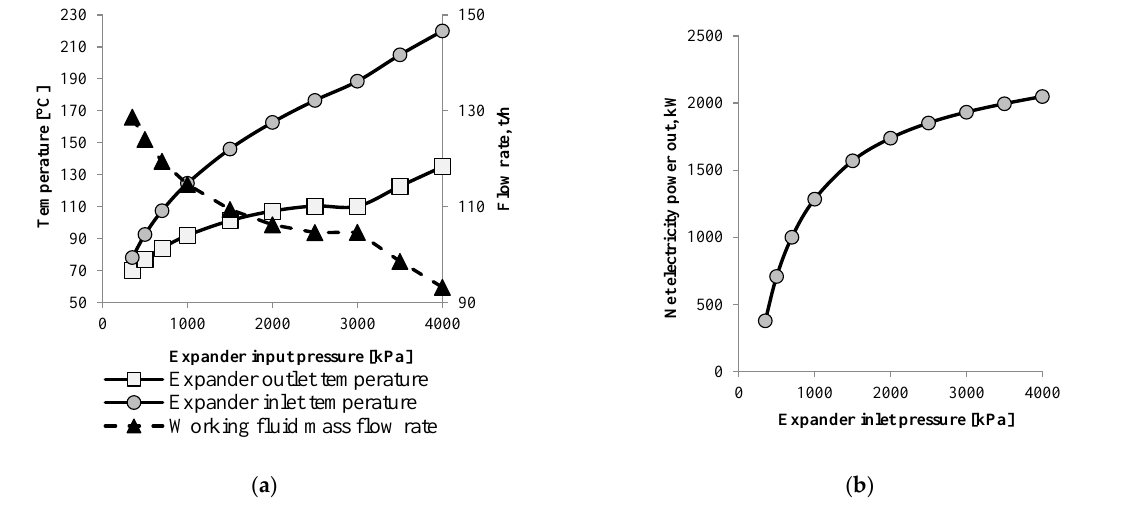
Figure 8. Influence of the expander inlet pressure on the working fluid parameters ( a ) and net power generation ( b ) for distillation integrated with the power generation.